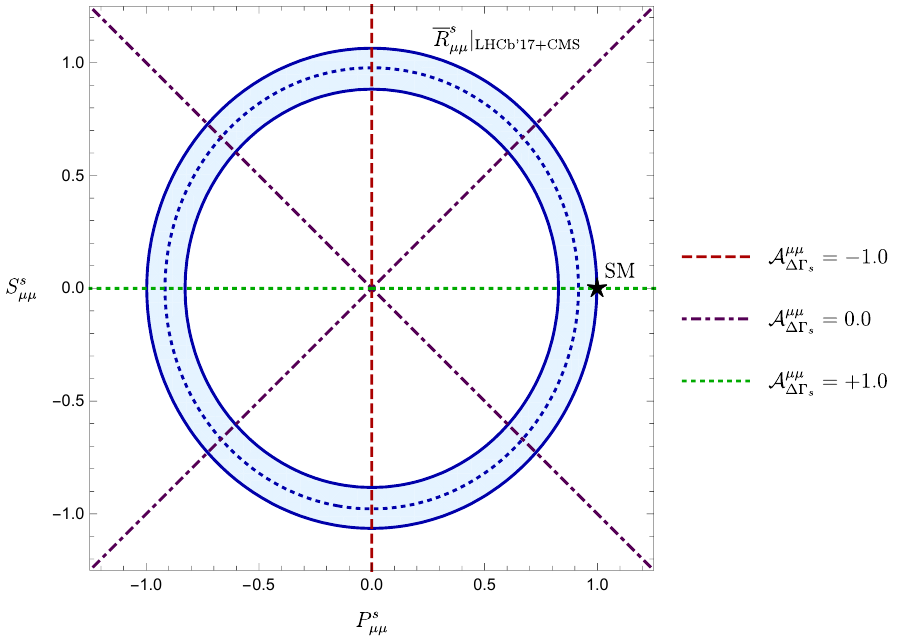
{ S s plane, assuming real coe(cid:14)cients with trivial CP-violating (cid:22)(cid:22) (cid:22)(cid:22) ; ’ (cid:22)(cid:22) 0 ; (cid:25) . The blue circular band corresponds to the current experimental P s S s 2 f g s . A future precise measurement of the e(cid:11)ective lifetime (cid:28) s (cid:22)(cid:22)